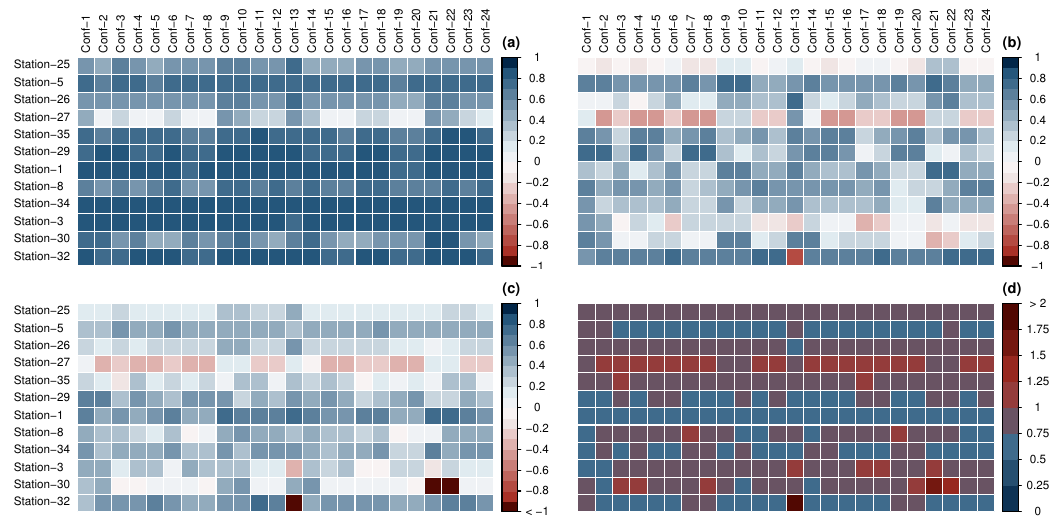
Figure 4. Matrix of statistics for precipitation: ( a ) correlation, ( b ) Kling-–Gupta efficiency (KGE), ( c ) Nash Sutcliffe Efficiency (NSE), and ( d ) standard deviation of measured data